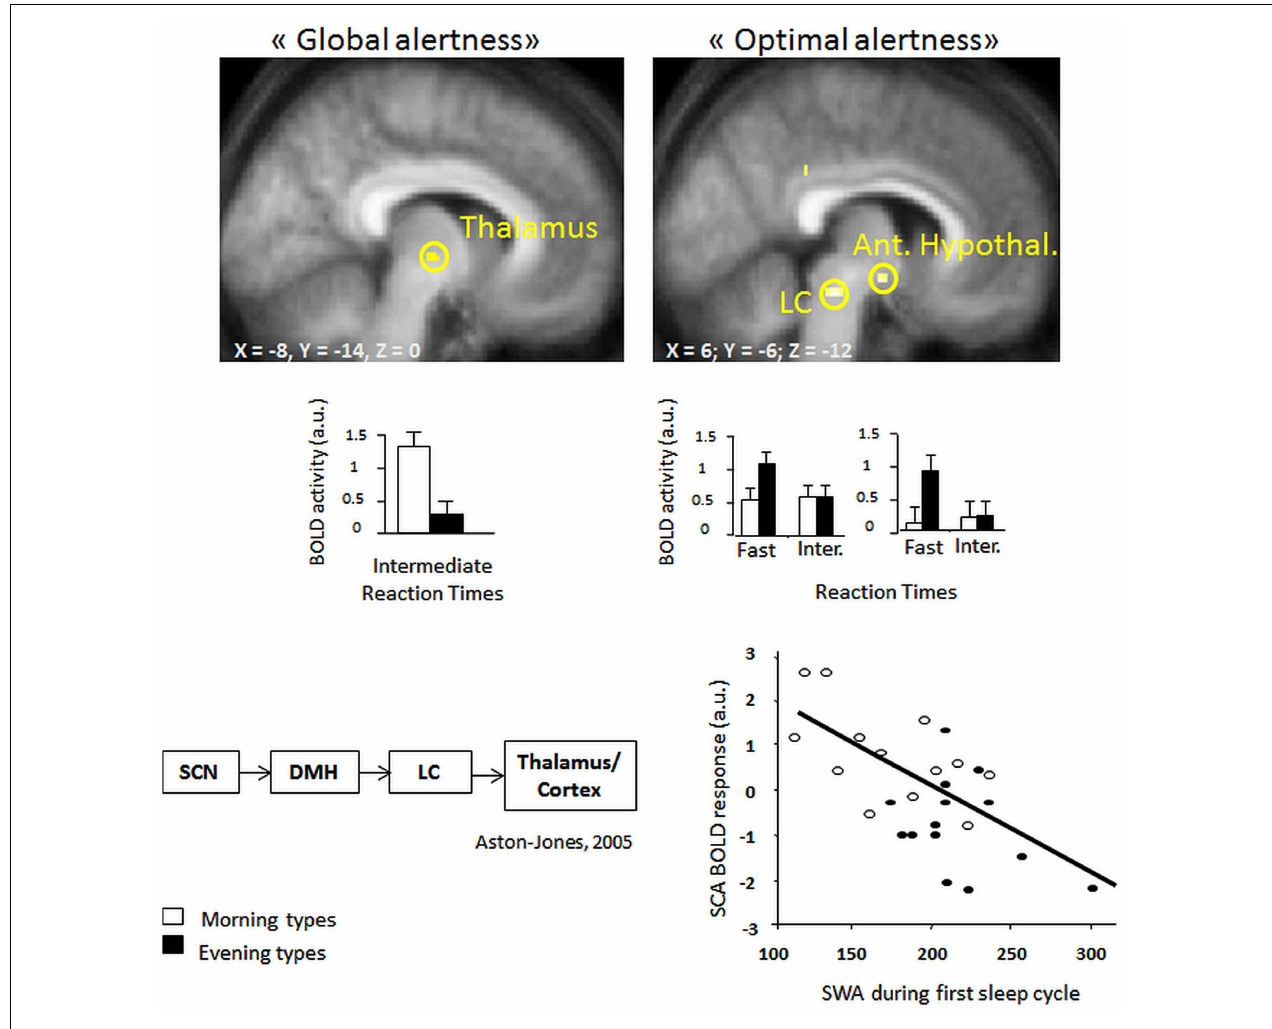
regions have been implicated in circadian arousal regulation, as illustrated by the model of Aston-Jones et al. (2001). (right, bottom panel) Finally, optimal alertness-related activity in the anterior hypothalamus (i.e., suprachiasmatic area) is negatively related to the amounts of EEG slow wave activity at the beginning of the night, which can be considered as a reliable marker of homeostatic sleep pressure build-up [modified from Schmidt et al.